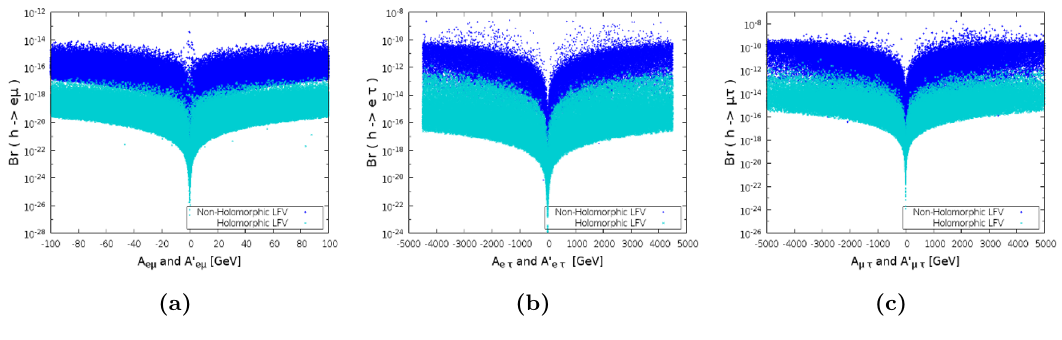
Figure 6. Figure 6(a) shows the variation of Br ( h e(cid:22) ) with A e(cid:22) and A 0 , in (cid:12)gure 6(b) e(cid:22) ! dependence of Br ( h e(cid:28) ) with A e(cid:28) and A 0 and 6(c) shows the variation of Br ( h (cid:22)(cid:28) ) with e(cid:28) ! ! A (cid:22)(cid:28) and A 0 . All points ful(cid:12)ll the analytical expressions of charge breaking minima given in (3.8) (cid:22)(cid:28) and (3.11) and the color coding is same as previous.